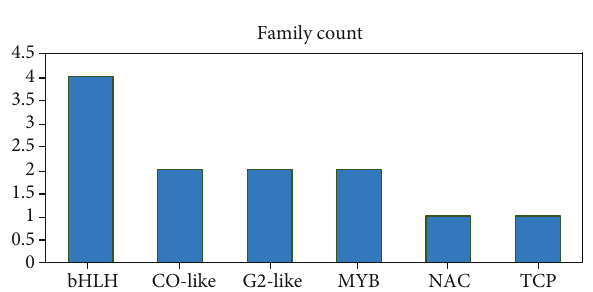
Figure 10: Distribution of downregulated TFs in response to drought